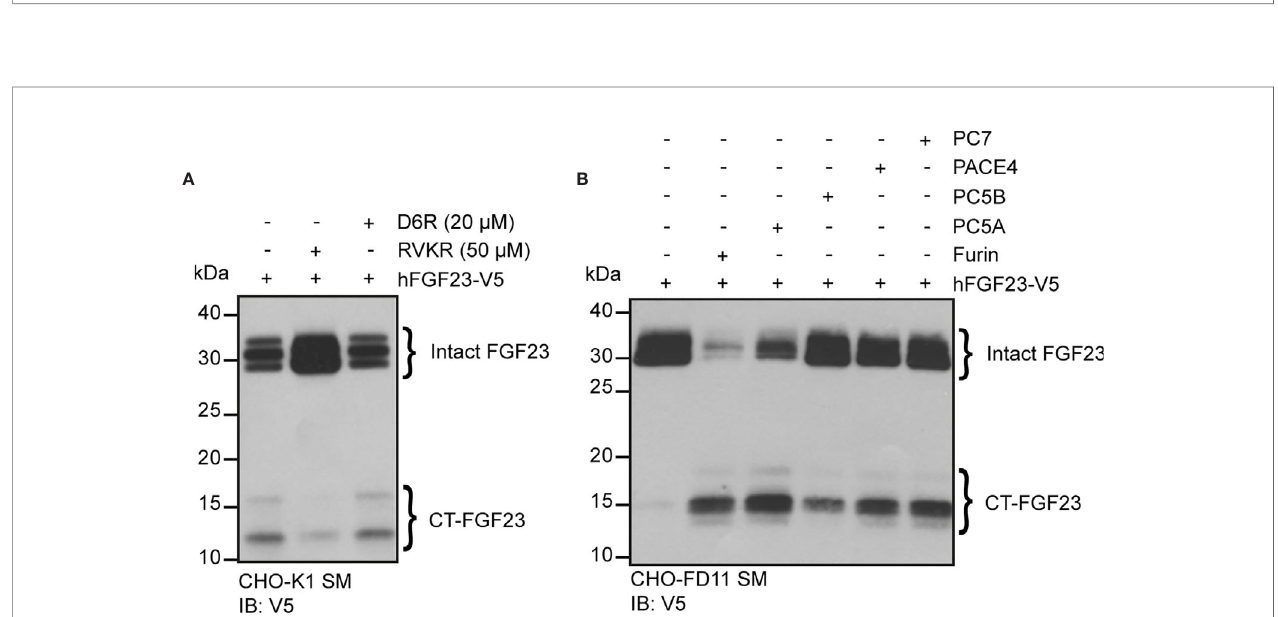
FIGURE 5 | Multiple proprotein convertases can process FGF23 in mammalian cells. (A) Western blot analysis of the secretion media (SM) from CHO-K1 cells transfected with V5 tagged human FGF23 (hFGF23-V5) and cultured in the absence ( – ) or presence (+) of PC inhibitors, decanoyl-RVKR-CMK (RVKR) (50 m M) or hexa- D-arginine (D6R) (20 m M). (B) Western blot analysis of the secretion media (SM) from CHO furin-de fi cient FD11 cells co-transfected with V5 tagged human FGF23 (hFGF23-V5) and proprotein convertase Furin, PC5A, PC5B, PACE4 or PC7. Intact and processed C-terminal (CT) FGF23 forms are detected with V5